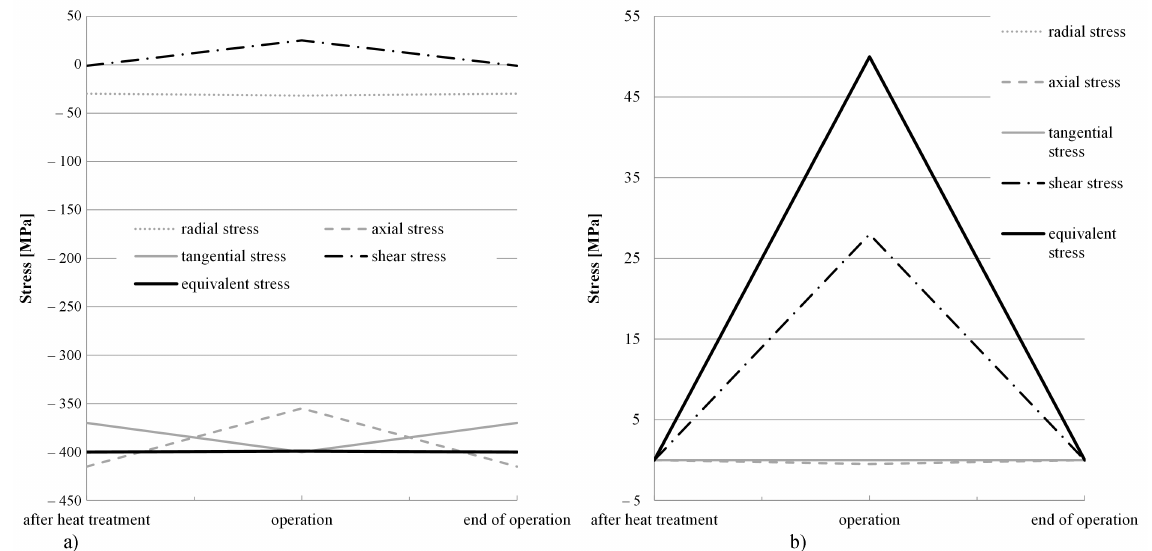
Figure 10. Stress tensor components and equivalent stress at the critical location of the starter clutch barrel for material ( a ) with heat treatment and ( b ) without heat treatment. Compressive axial, tangential and radial stresses introduced by the heat treatment have a favourable effect on the course of the equivalent